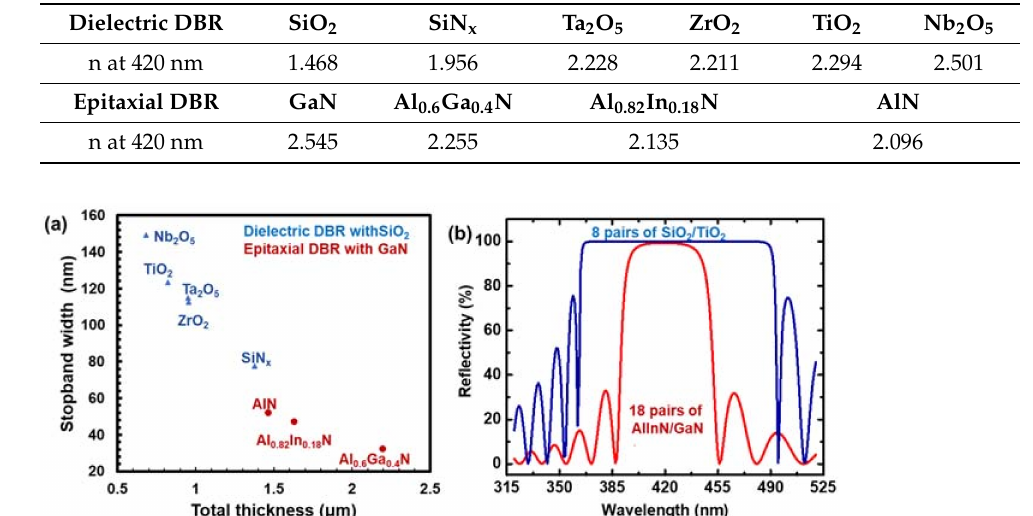
Figure 3. ( a ) Scatter plot of stopband width and a total thickness of ideal epitaxial and dielectric DBRs with R > 0.99 ( b ) Calculated reflectivity spectrum of selected